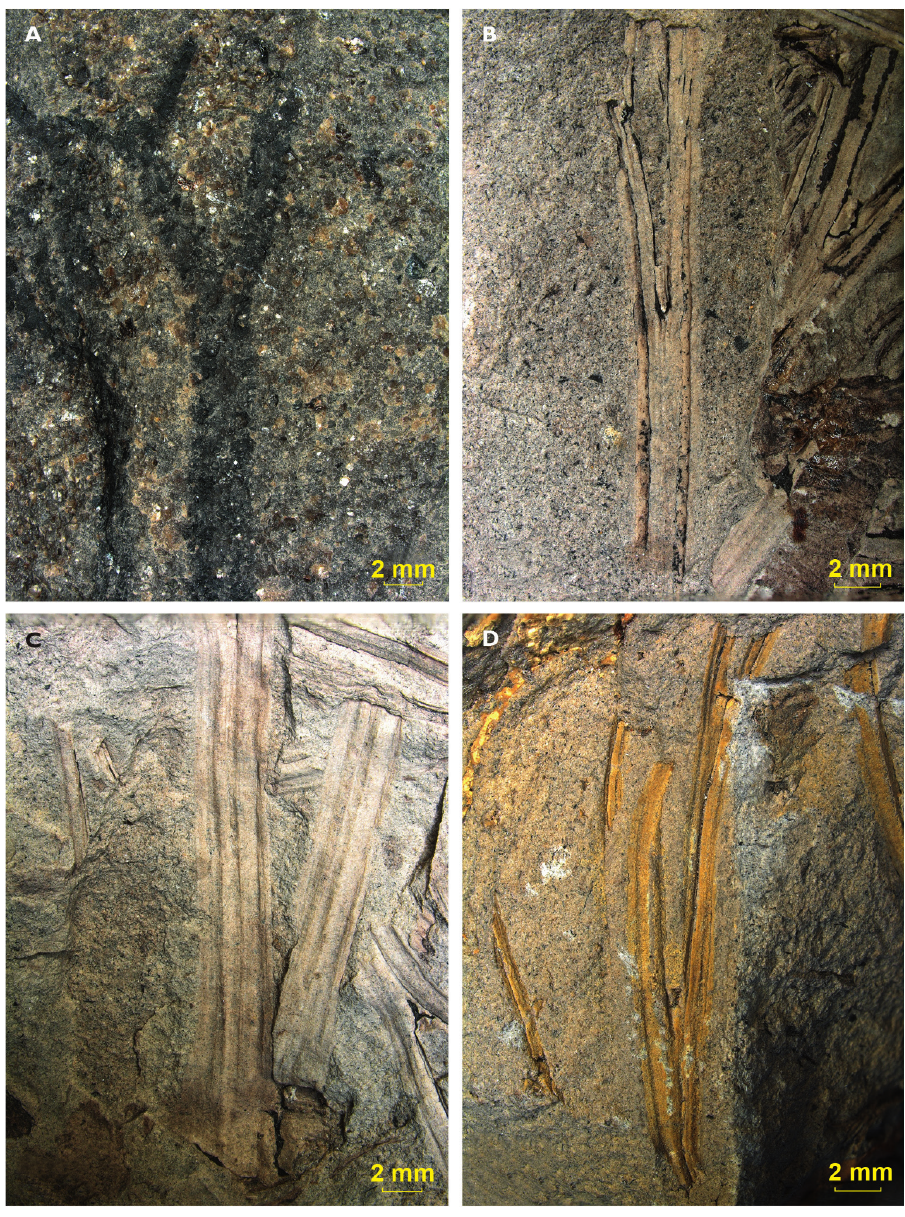
Figure 6. Leaf structures: A Leaf displaying two consecutive bifurcation angles, the second angle is larger than the first, sample 30, Ronchamp B Stomatal furrows as pronounced protrusions on the adaxial side of the leaf surface, note several thin striae between the furrows, sample 220 Mt Pelé C Stomatal furrows as pronounced depressions on the abaxial side of the leaf surface, note the midvein depression, sample 225 Mt Pelé D Venation in a Dicranophyllum gallicum leaf, note the trajectory of the midvein from the inner edge of the second leaf segment, gradually back to the centre position before the second bifurcation, sample 157, Mt